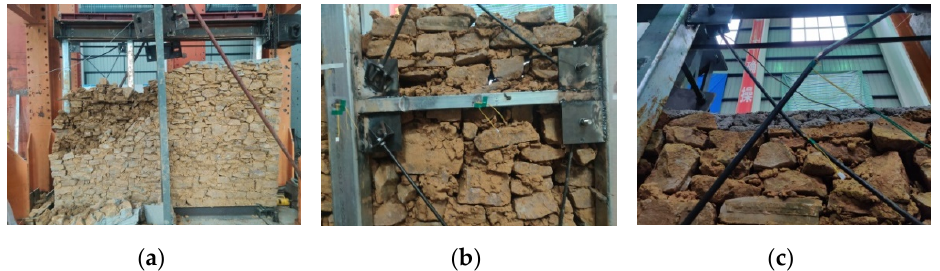
Figure 11. Test phenomena of FW-6 specimen: ( a ) Partial collapse of the left part wall; ( b ) Buckling and tear failure of the horizontal brace; ( c ) Deformation of upper bracings.